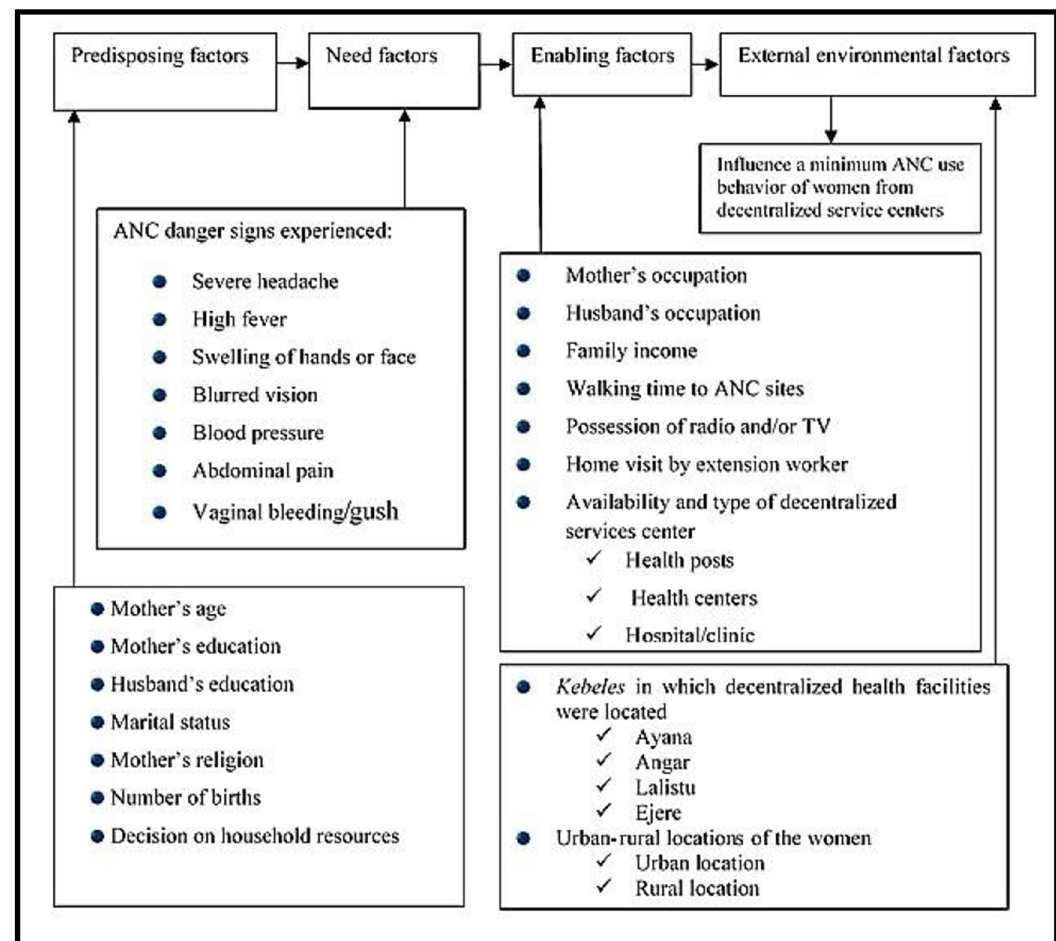
Fig 1. Conceptual framework for health-service utilization behavior modified from Andersen’s behavioral